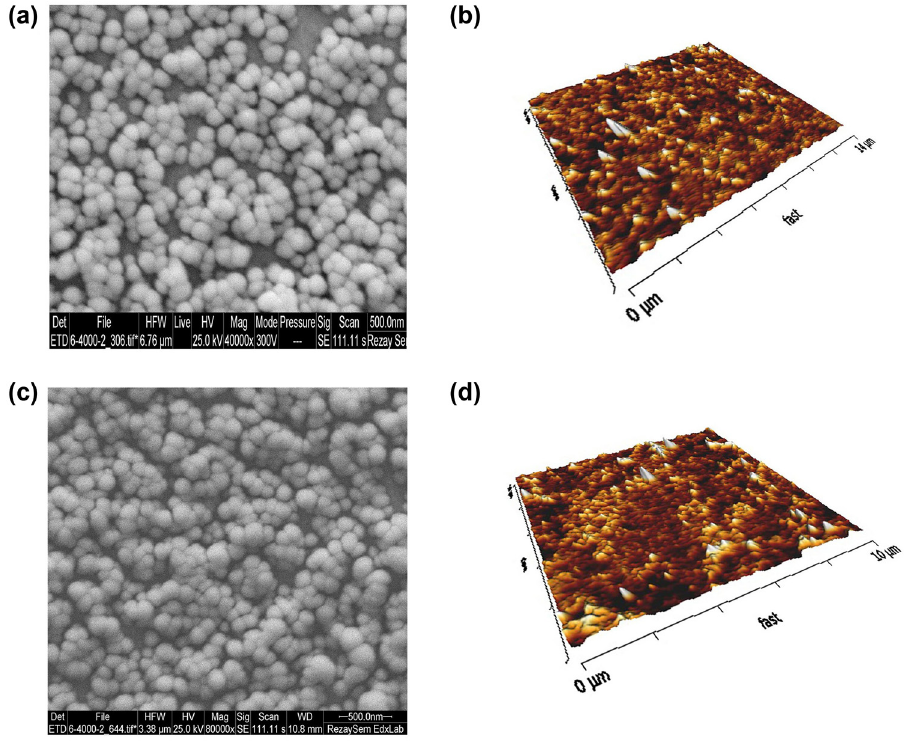
Figure 3: The microscopy imaging obtained by SEM and AFM; ( a ) SEM imaging of Nio - GGE. ( b ) AFM imaging of Nio - GGE. ( c ) SEM imaging of Nio - HHE. ( d ) AFM imaging of Nio - HHE.